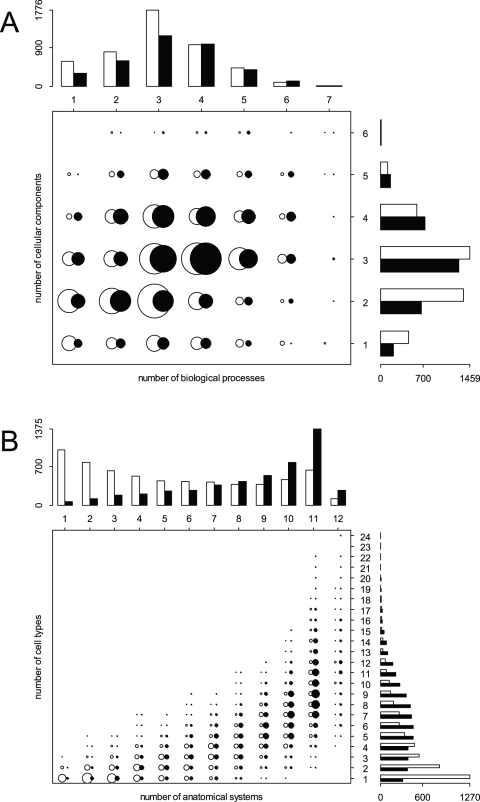
Functional classification and expression profiles of MS (white bars and circles) and PS (black bars and circles) genes in humans.A. Functional classification of genes according to the GO ontology. Note that a gene may be associated with more than one function and hence may belong to more than one functional group. The chart shows a clear and positive relationship between the number of distinct biological processes and the number of cellular components in which gene products are involved. Top (right): histogram of the number of distinct biological processes (cellular components) for MS and PS genes. The list of cellular components and biological processes is shown in Figure S4. B. Expression profiles of MS and PS genes in humans using ESTs and the eVOC ontology. The chart shows a clear and positive relationship between the number of distinct anatomical systems and the number of cell types in which the genes are expressed. Top (right): histogram of the number of distinct anatomical systems (cell types) for MS and PS genes. The cell types and the list of anatomical systems are given in Table S2. The circle areas are proportional to the number of genes. Information for MS and PS genes is shown in white and black, respectively.